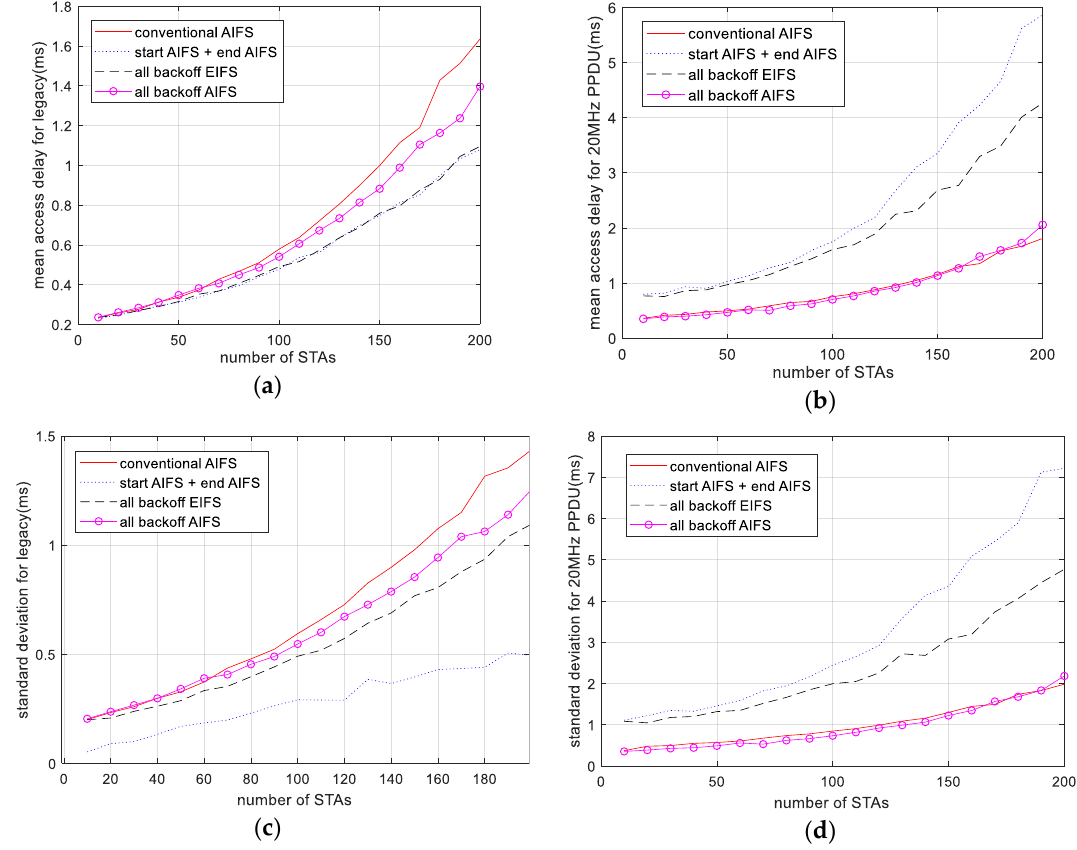
Figure 9. Comparison between channel access schemes in terms of effects on transmissions in secondary channel and mean access delay of 20-MHz frame: ( a ) mean access delay of 10-MHz frame sent in the secondary channel; ( b ) mean access delay of 20-MHz frame; ( c ) standard deviation of 10-MHz frame sent in the secondary channel; ( d ) standard deviation of 20-MHz frame.